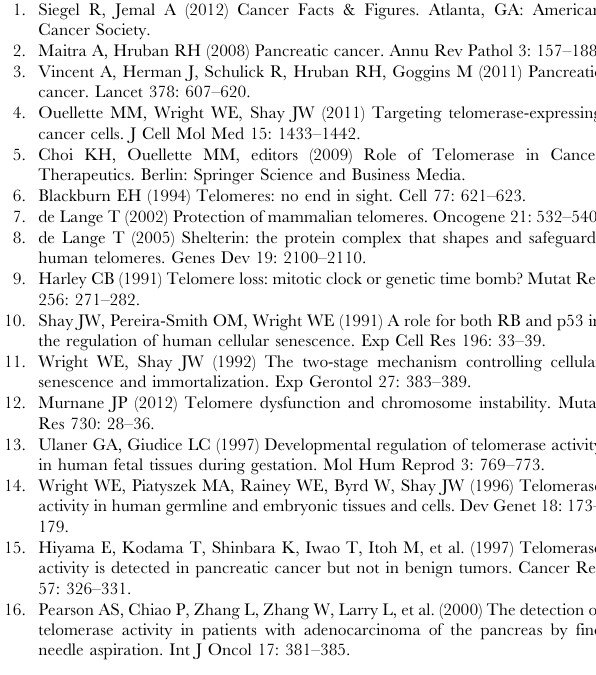
signal intensity was plotted as a function of the estimated telomere size, as described in the Materials and Methods section. Telomere size distributions in the control populations (CTR, MIS) did not change as a function of population doublings. For the sake of simplicity, only the first time point is shown for each of the control populations (CTR, MIS). Figure S5 SA- b -galactosidase activity in the floating dead cells harvested from the GRN163L-treated CD18 cells. At the end of the CD18 growth curve, floating cells were collected from the GRN163L-treated (GRN) and control (CTR, MIS) populations. Cells were resuspended in 10 pellet volumes of medium. Suspended cells were fixed, washed, and stained for SA- b -galactosidase activity. Washes before steps were performed by centrifugation.